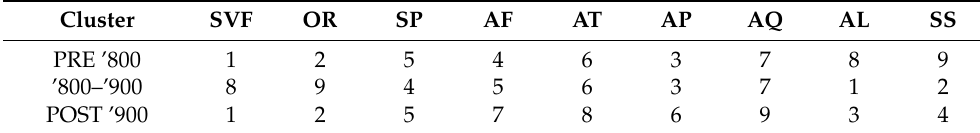
Table 3. Order of indicators preferability of urban pattern